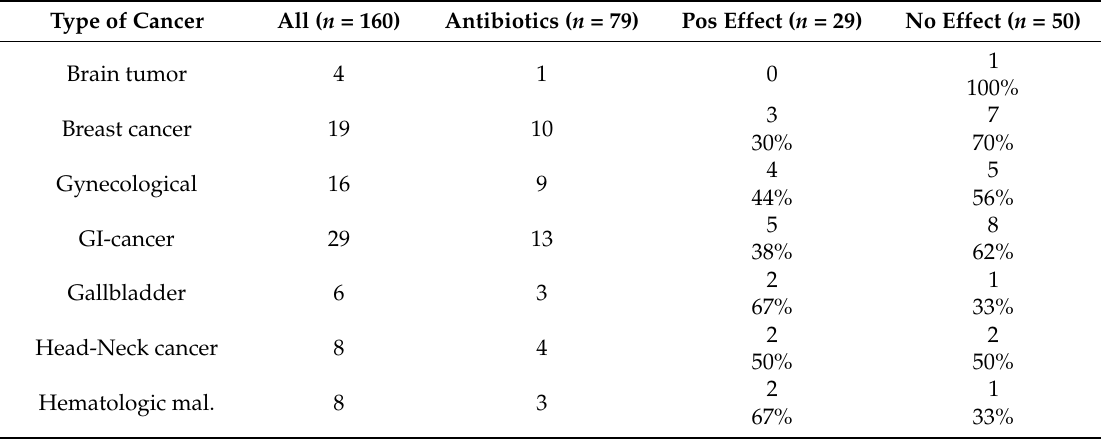
Table 3. Type of cancer in the whole cohort and among those with antibiotic treatment. In column 3 and 4 patients with positive effect (Pos effect) or unknown/no effect (No effect) of the antibiotic treatment is presented and percentage intends of those with that specific cancer form receiving antibiotics (column